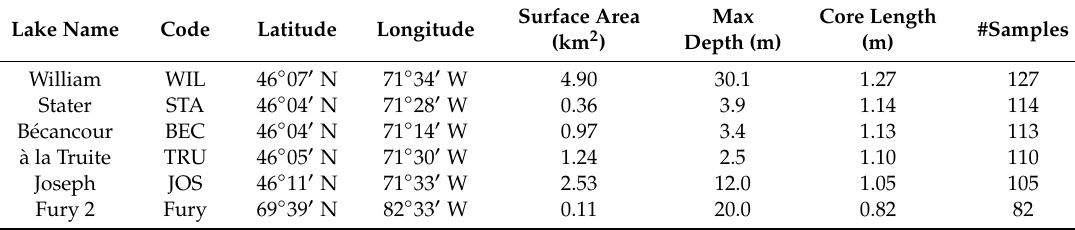
Table 1. Description of sampling sites.